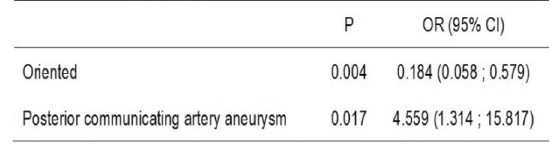
Table 2 (abstract 001113). Multivariate logistic regression for the DCI. Variables were selected using the best subset regression and BIC